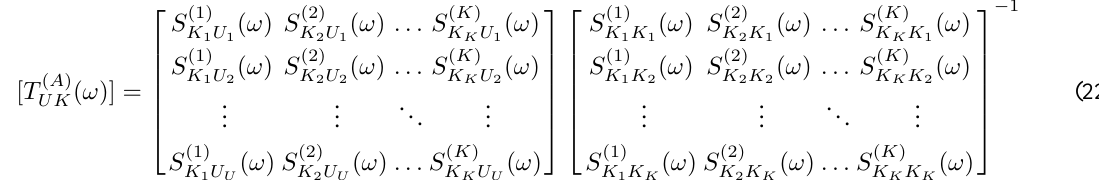
Fig. 3. Calculated and measured spectral